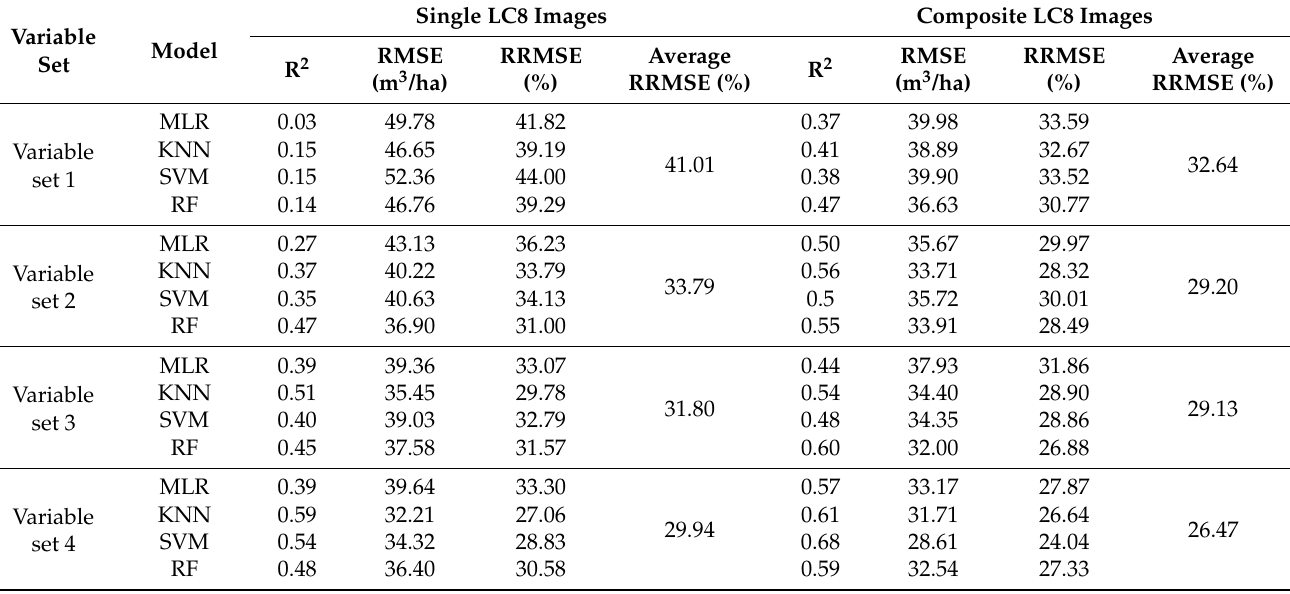
Table 3. The results of estimated FSV with different variable set in eucalyptus